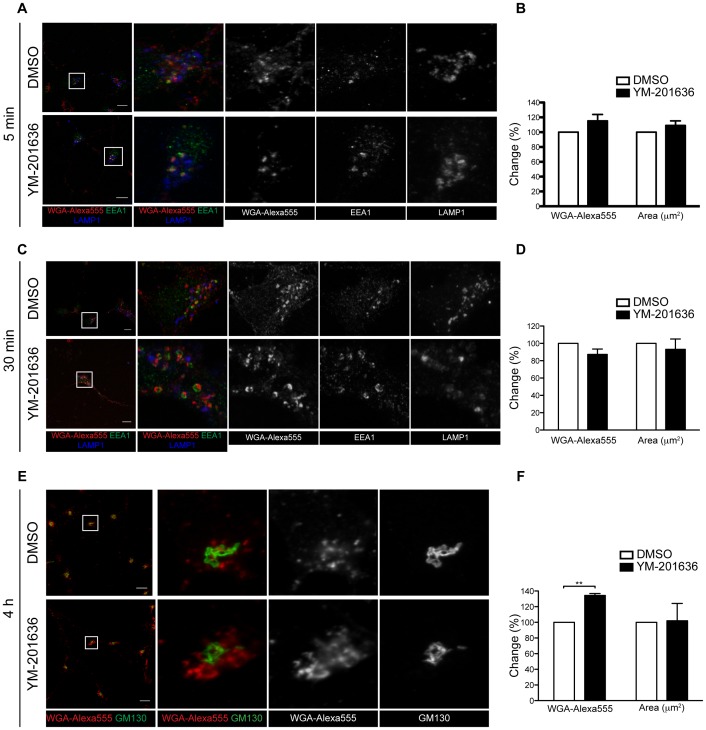
Effect of YM-201636 on WGA trafficking by immunocytochemistry.Primary hippocampal neurons were treated with DMSO or 1 µM YM-201636 for 4 h, then supplemented with 5 µg/ml WGA-Alexa555 for the final 5 min (A,B) or 30 min (C,D). Cells were fixed, immunolabelled for EEA1 and LAMP1, and imaged by confocal microscopy. (B,D) The intensity of WGA-Alexa555 per µm2 in the cell body and the total area of the cell body were determined in the YM-201636–treated cells relative to DMSO. (E,F) Primary hippocampal neurons were treated with DMSO or 1 µM YM-201636 in the presence of 5 µg/ml WGA-Alexa555 for the full 4 h. Cells were fixed, immunolabelled for GM130 and imaged by confocal microscopy. (F) The amount of WGA-Alexa555 fluorescent intensity in the cell body/µm2 of the YM-2016363 treated cells was determined relative to DMSO. The area of the cell bodies analysed was also determined (mean ± SEM, n = 3 independent experiments, 9–28 cells per experiment). Significances relative to DMSO **p<0.01. Scale bar = 10 µm.